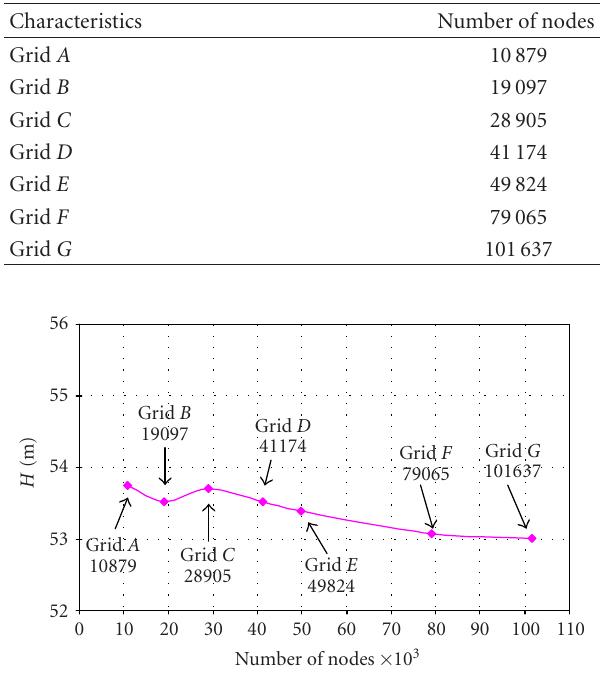
Figure 3: Influence of grid size on impeller